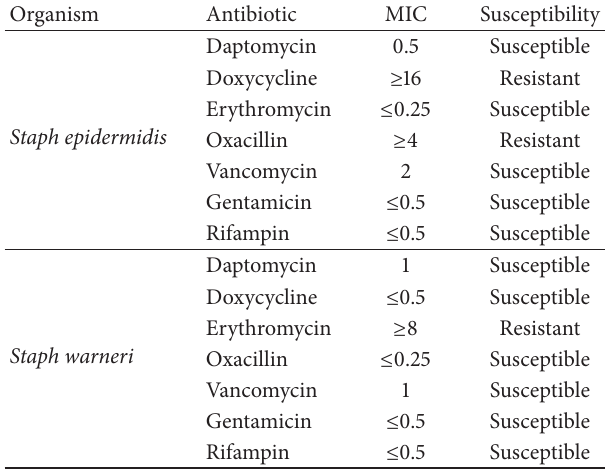
Table 1: Blood culture results and susceptibility profile for Staphy- lococcus epidermidis isolated from the central venous catheter.